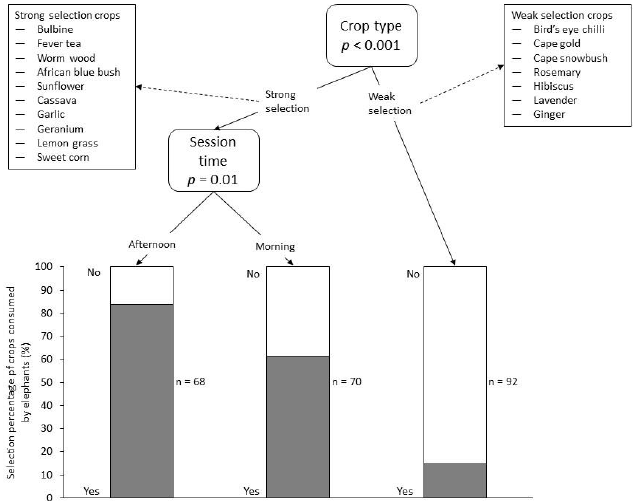
Figure 5. Results of the classification tree analysis representing the selection percentage of plant or crop types consumed by elephants in the cafeteria experiments.